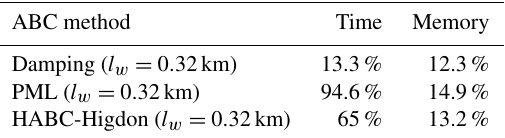
Table 5. The percent growth of wall clock time and RAM usage, as compared to the no-ABC case ( l w = 0 . 0km). The measures are related to a source of a single shot wave of the FWI execution, with a multiscale approach, for the velocity model that is matched with Marmousi. It this case, the execution of FWI with no-ABC required 75s of wall clock time and 6.11GB of memory usage. ABC method Damping ( l w = 0 .